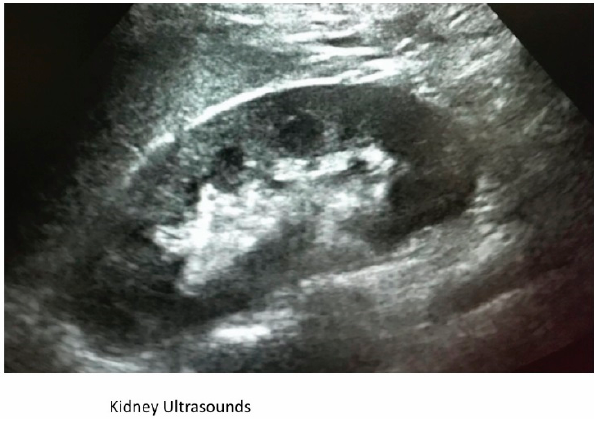
Figure 1. Ultrasound showing a kidney of normal size and echogenicity.